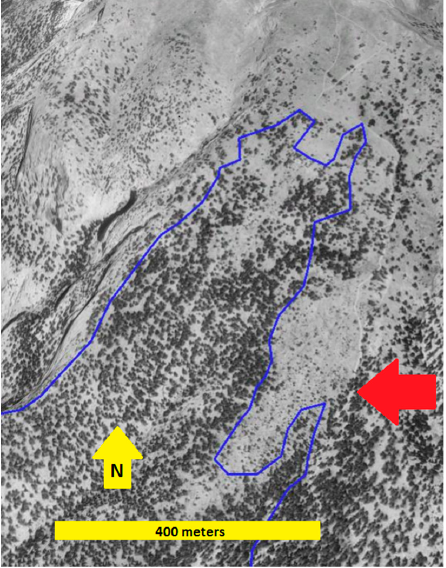
Figure 2. Remote sensing imagery of Mt. Washington in the 1990s, prior to the 2000 fire (blue line). A previously cleared forest section (red arrow) showed on-the-ground evidence of wildfire-killed trees.